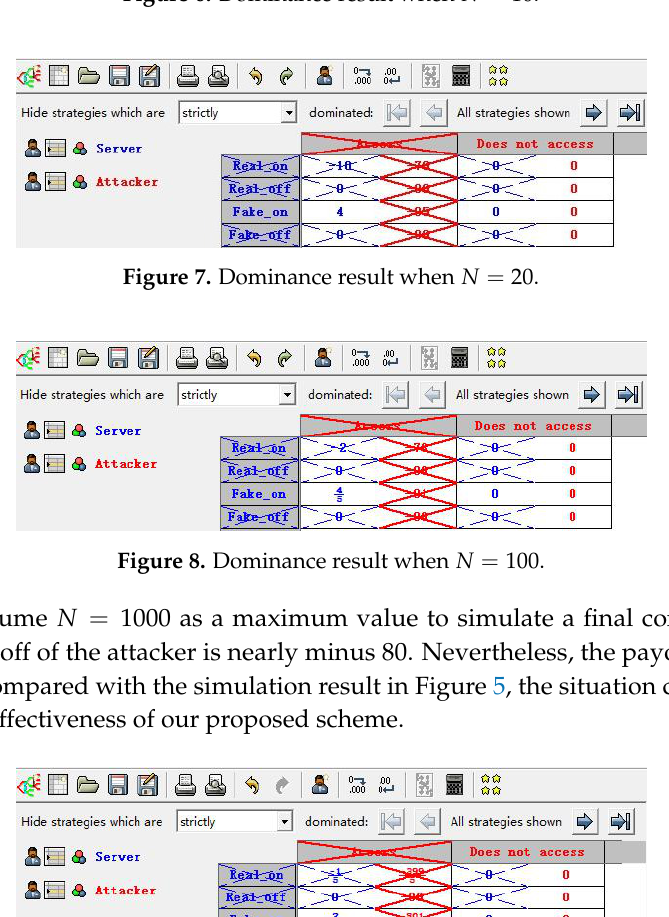
Figure 6. Dominance result when N = 10.